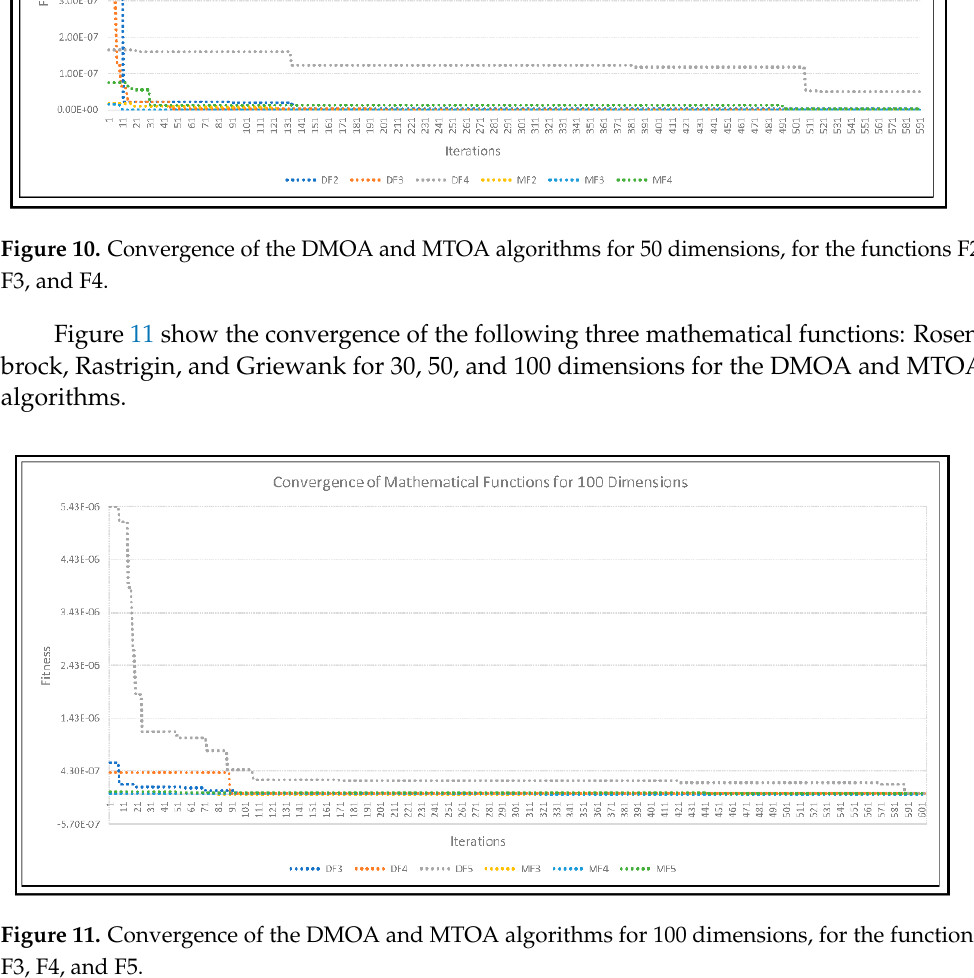
Figure 11. Convergence of the DMOA and MTOA algorithms for 100 dimensions, for the functions F3, F4, and F5.